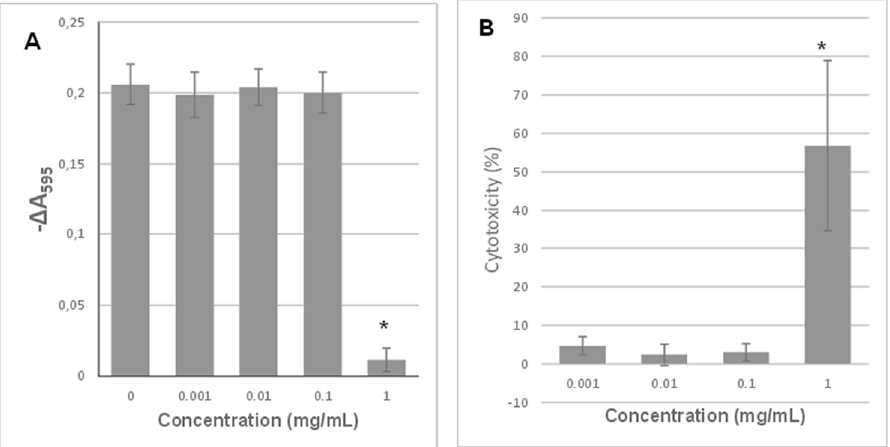
Figure 11. Effect of 24 h exposure to Zn[(acac)(LPhe)H 2 O] on ( A ) the resazurin reduction by CCD-11Lu cells; ( B ) LDH release from CCD-11Lu cells. Each bar represents the mean ± SD; * p < 0.05 compared to the control.